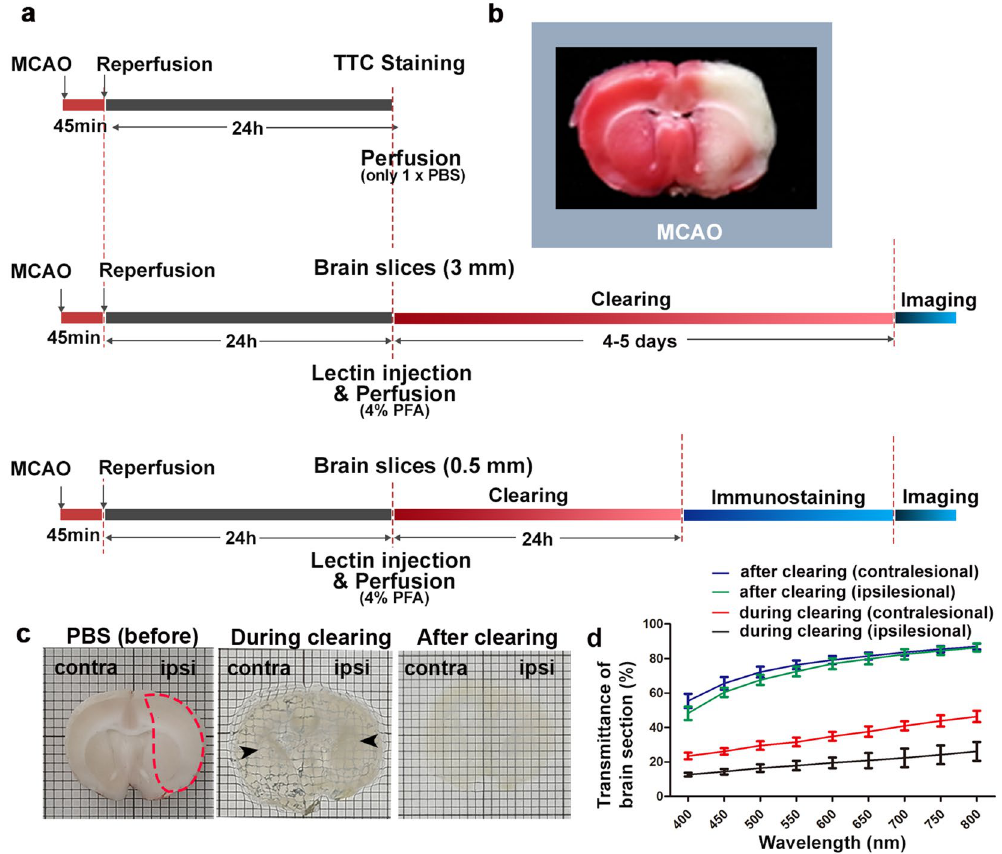
Figure 1. Workflow of the protocol. ( a ) Diagrams showing the overall experimental procedure. ( b ) Brain slice from MCAO rat stained with 2% TTC solution (n = 1 animal). ( c ) Bright-field images of MCAO-induced rat brain sections (3-mm-thick slice) before clearing (in PBS), during clearing (clearing solution for 24 h), and after clearing (matching RI). Grid size, 1 mm × 1 mm. The arrowheads show that the visibility of the background grid differs. ( d ) Transmittance curves of contralateral and ipsilateral brain sections during (clearing solution for 24 h) and after clearing (mean ± SD, n = 3 brain sections for each group). contra, contralesional region; ipsi, ipsilesional